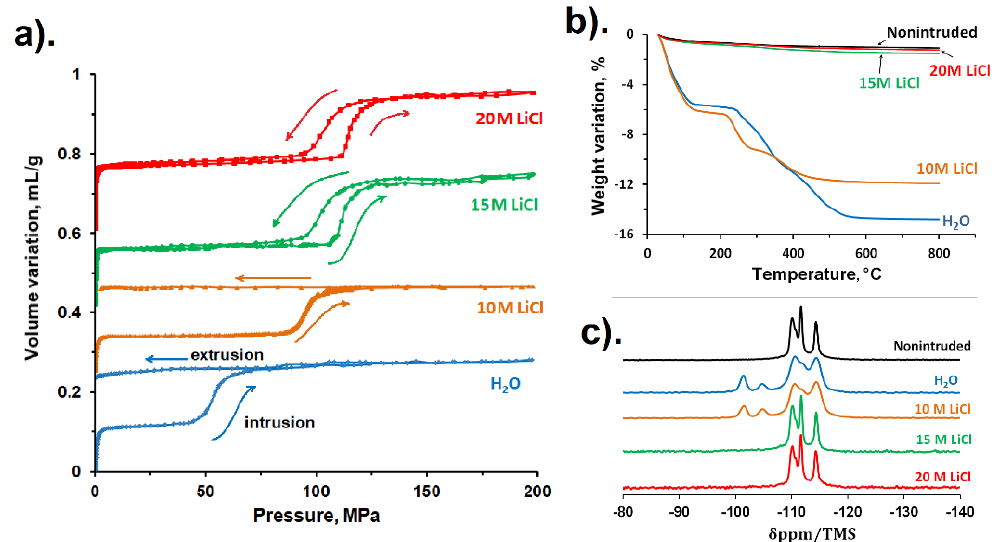
Figure 7. ( a ) Intrusion–extrusion curves for “*BEA-type zeosil–H 2 O” and “*BEA-type zeosil–LiCl aqueous solution” systems. ( b ) Thermogravimetric curves of *BEA-type zeosil samples before and after intrusion–extrusion of water and LiCl aqueous solutions. ( c ) 29 Si MAS NMR spectra of *BEA-type zeosil samples before and after intrusion–extrusion experiments with water and LiCl aqueous solutions. The results are taken from